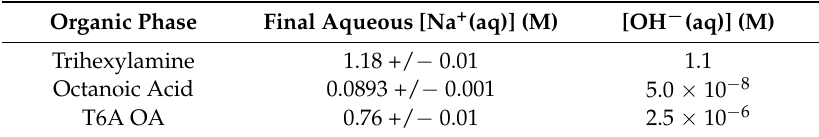
Table 3. Aqueous phase composition after extraction from basic solution. Initial aqueous phase: 1.00M